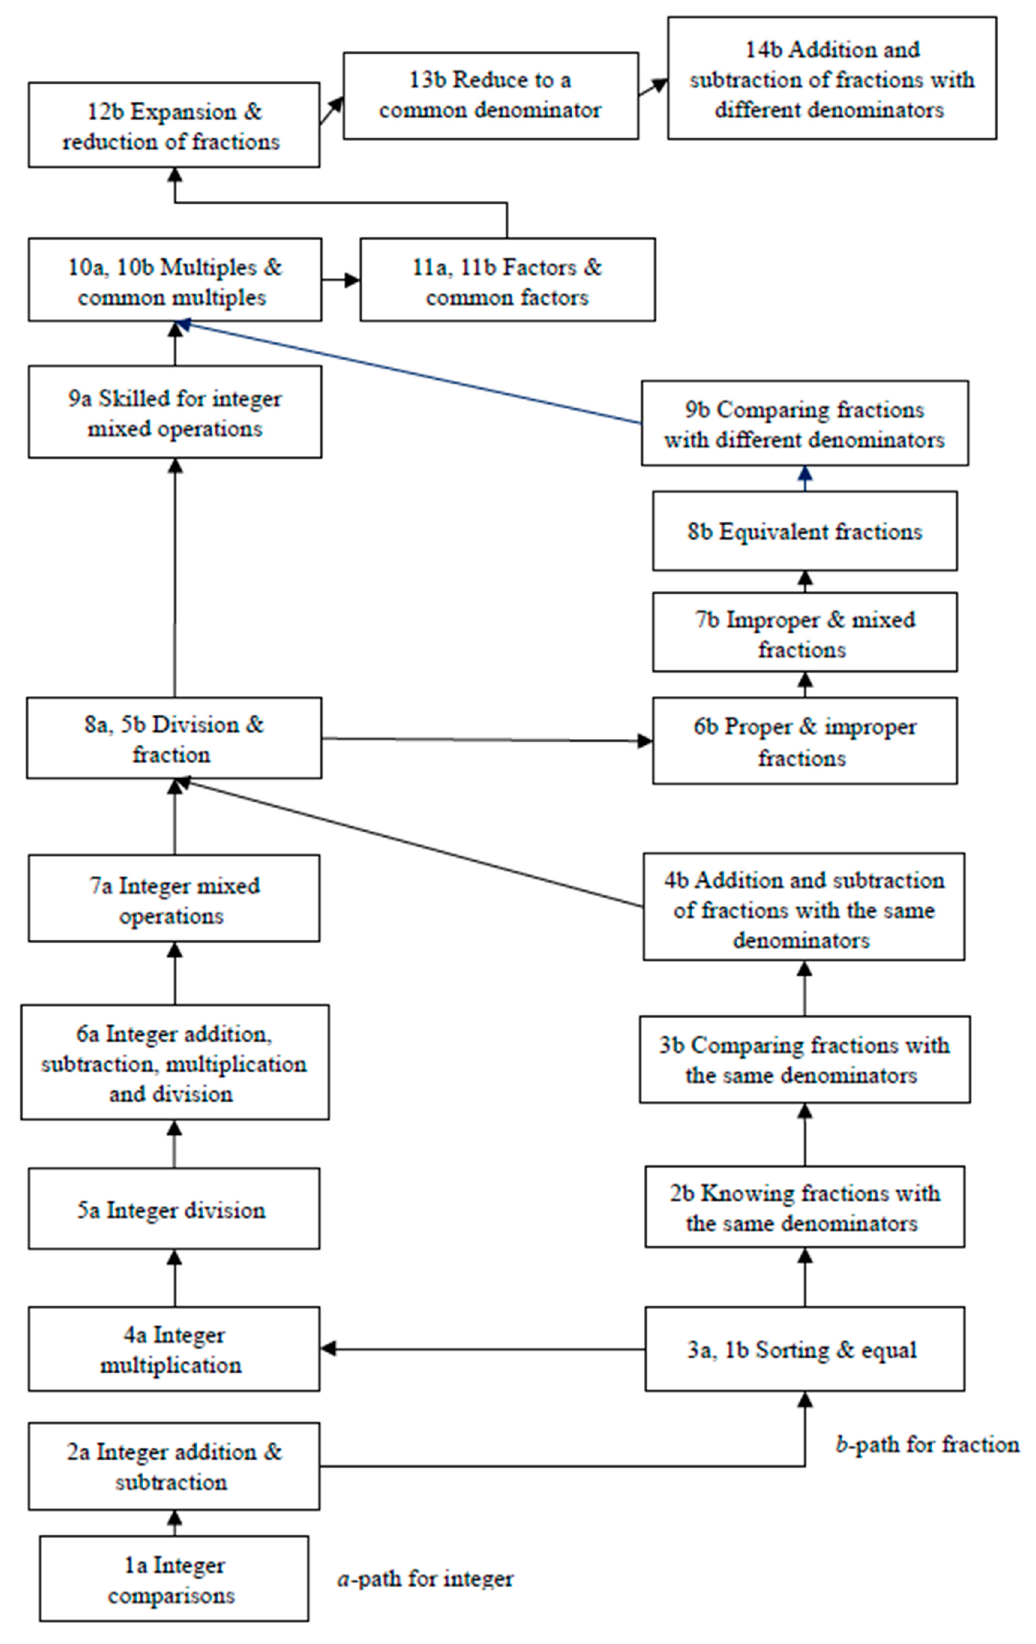
Figure 1. Gagné learning hierarchy diagram for integers and fractions. Figure 1. Gagn é learning hierarchy diagram for integers and